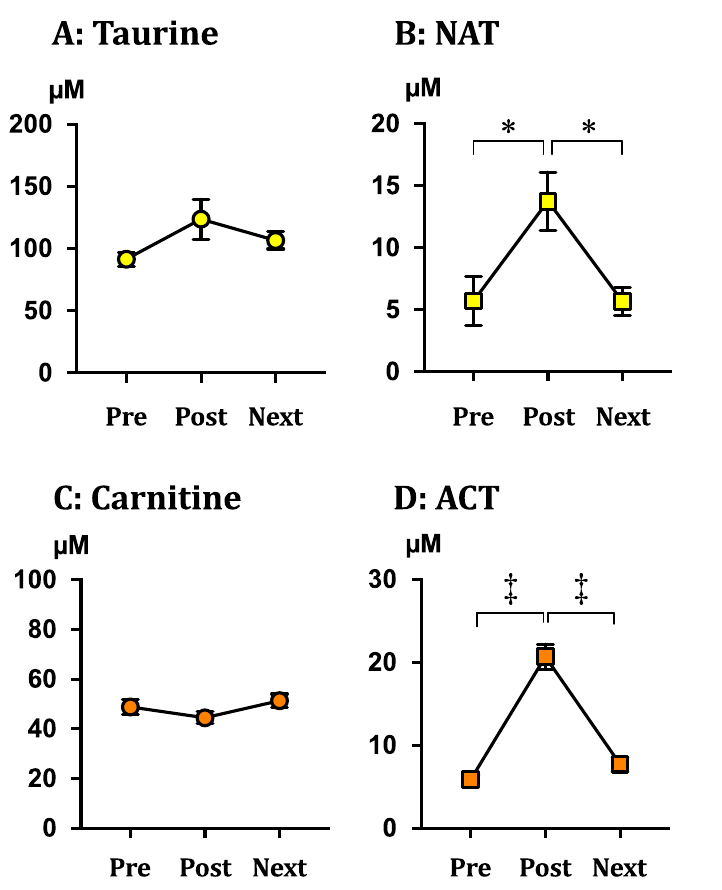
Figure 2. Serum levels of taurine ( A ), carnitine ( C ), and its acetylated forms, NAT ( B ) and ACT ( D ), before and after the endurance exercise. Serum was collected 1 day before (Pre), immediately after (Post), and the day after (Next) the full-marathon race. Taurine, NAT, carnitine, and ACT were simultaneously measured using an HPLC-MS/MS system. The data shown refer to the mean ± SEM. * p < 0.05 and ‡ p < 0.0001 were analyzed by one-way ANOVA post-hoc tests. Abbreviations: NAT; N - acetyltaurine, ACT; acetylcarnitine. Table 1. Serum levels of biochemical energy-related parameters before and after the exercises. Parameter